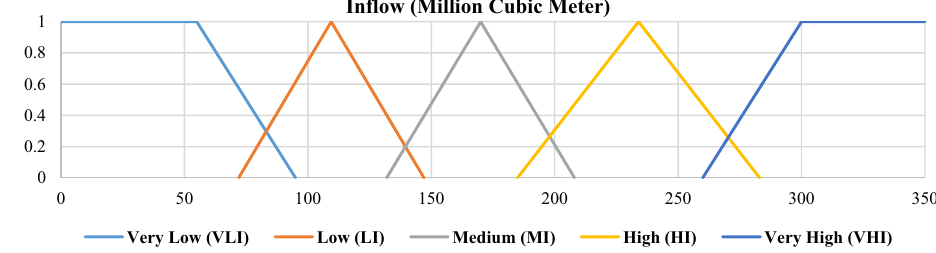
Fig. 2 Membership function for the universe inflow Fig. 3 Membership function for the universe